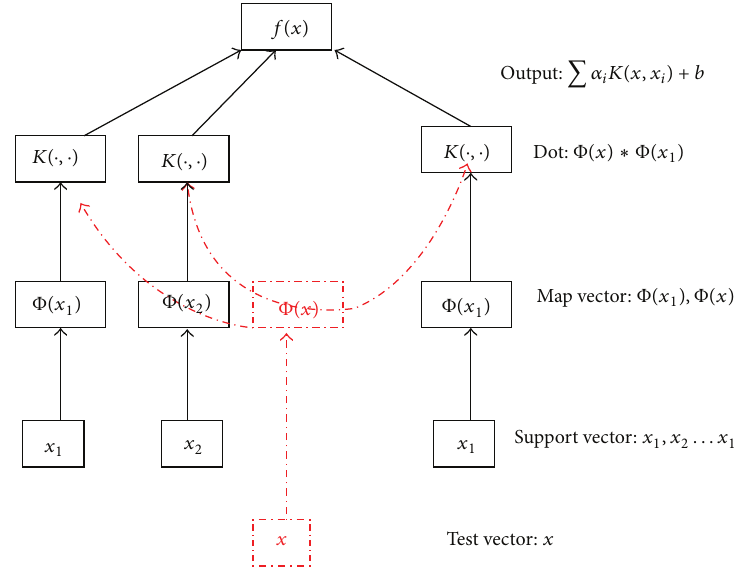
Figure 4: The steps of SVR processing.